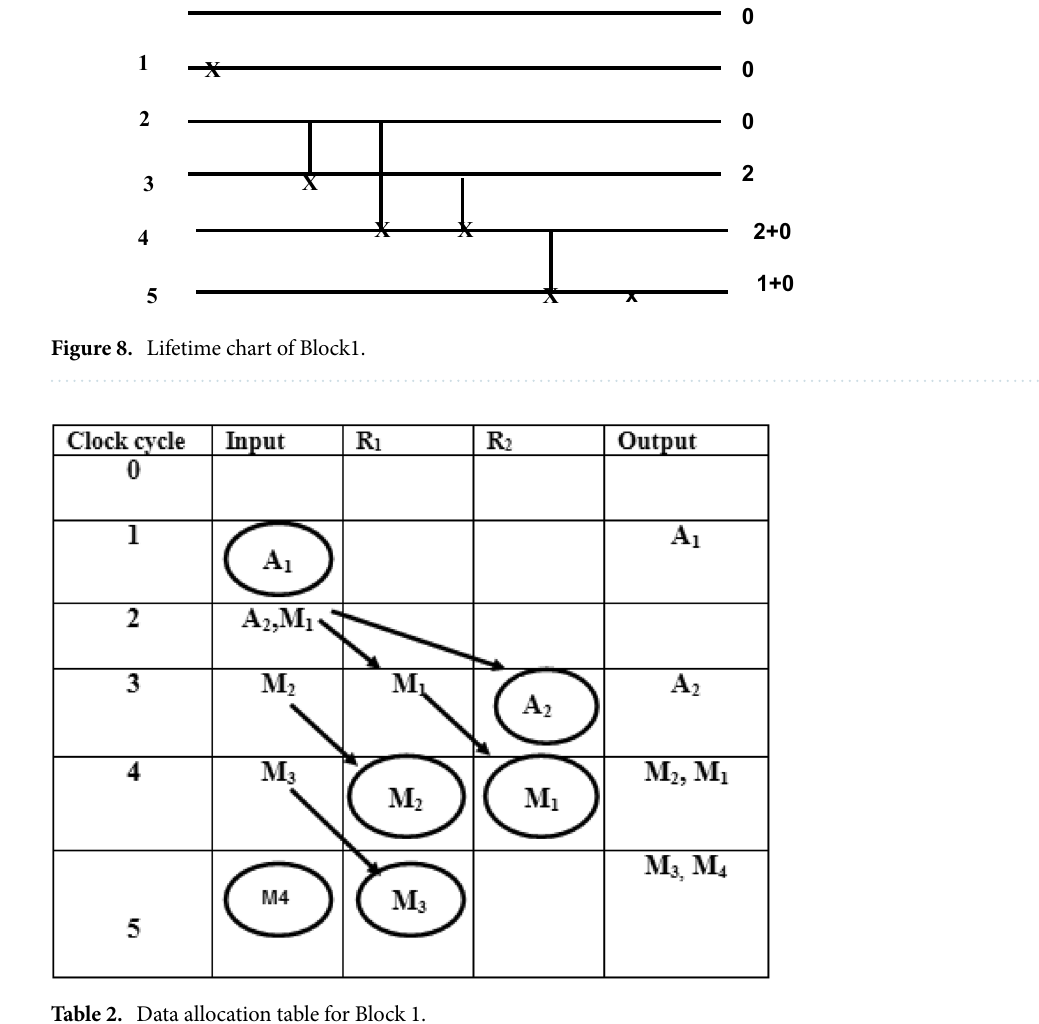
Table 2. Data allocation table for Block